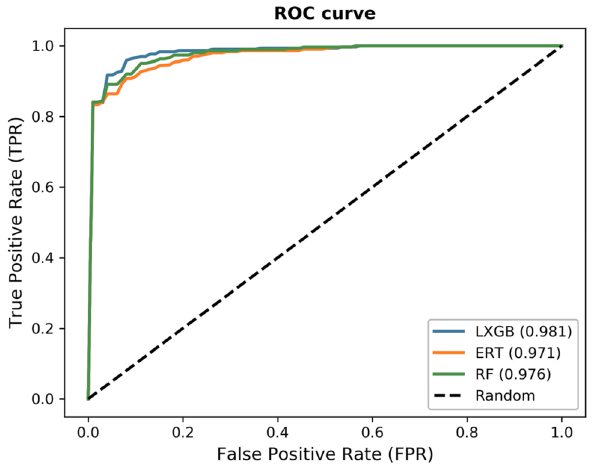
Figure 2. ROC curves of the classifiers.